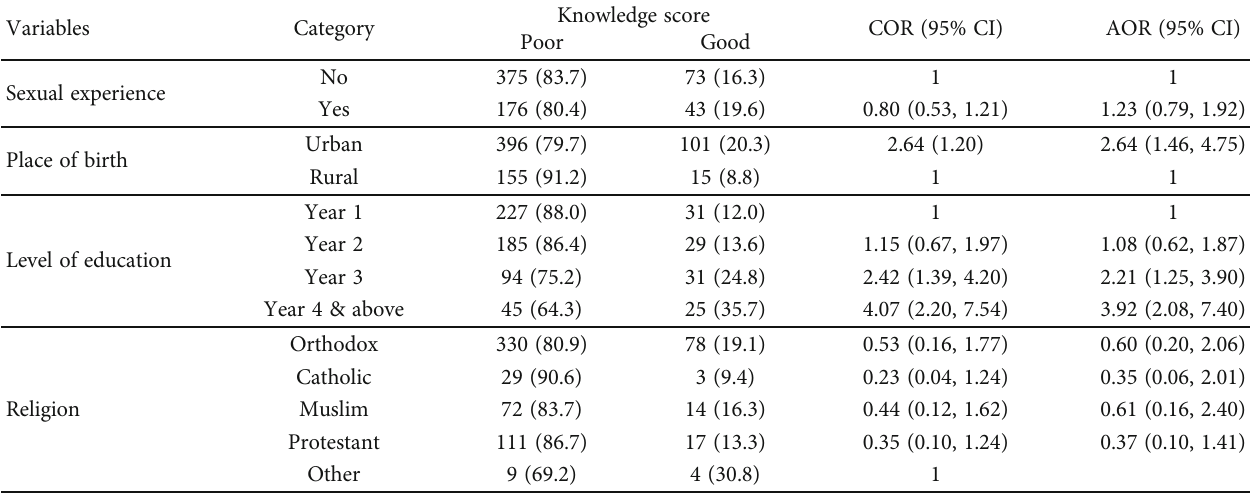
Table 5: Association between sociodemographic characteristics and knowledge score of cervical cancer among Adama Science and Technology University, Adama, Ethiopia, May 2014.